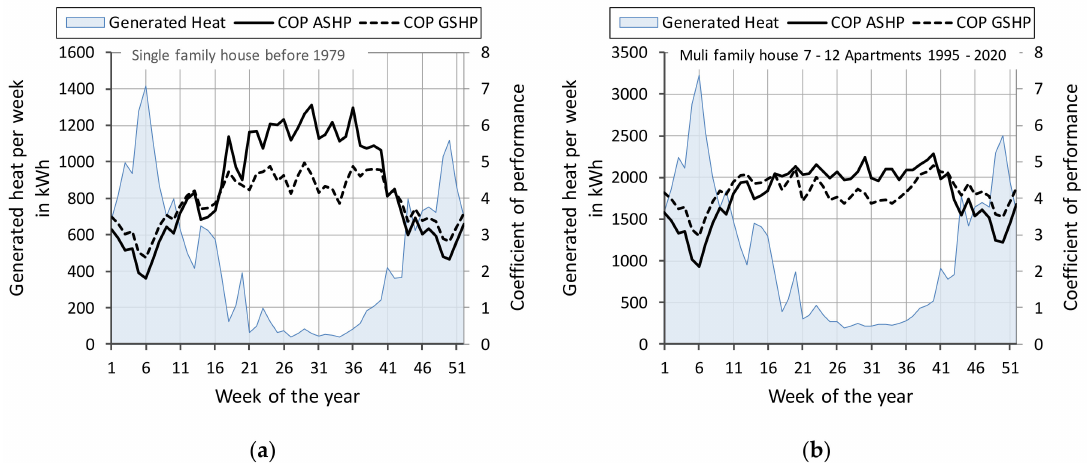
Figure 4. Comparison of the COP and the generated heat of an air source heat pump and a ground source heat pump for a single family house before 1979 ( a ) and a multi-family house of the building age class 1995–2020 ( b